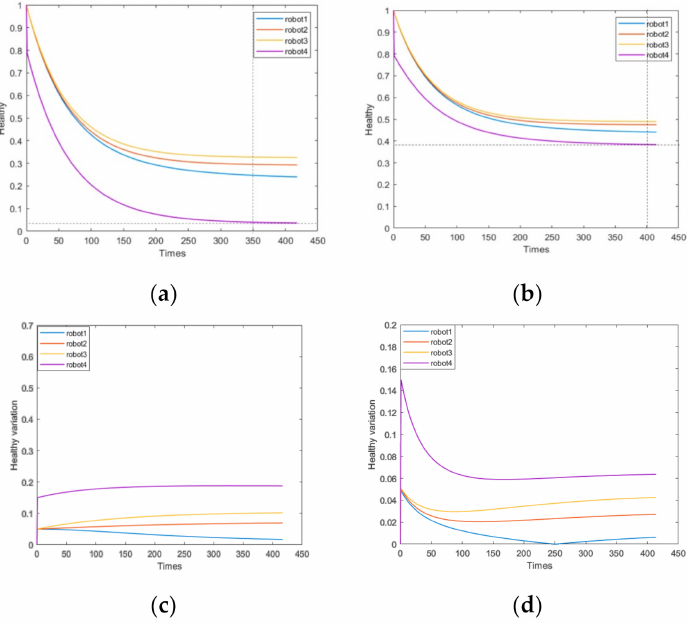
Figure 12. Comparison before and after adding HOM in the second scenario: ( a ) h i ( t ) of the robot under normal conditions; ( b ) h i ( t ) of the robot under HOM; ( c ) e i ( t ) under normal conditions; ( d ) e i ( t ) under